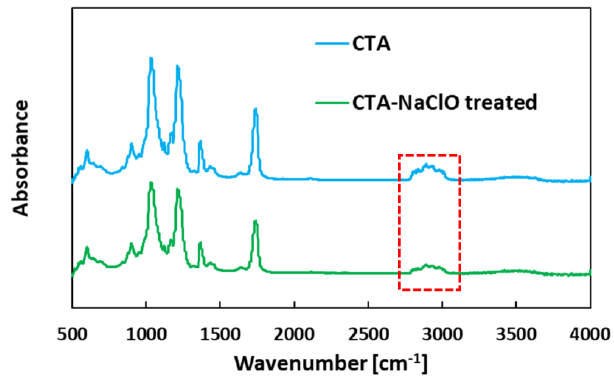
Figure A3. FT − IR of CTA samples before and after sodium hypochlorite immersion. Samples are immersed in sodium hypochlorite solution with 2000 ppm concentration for 7 days.